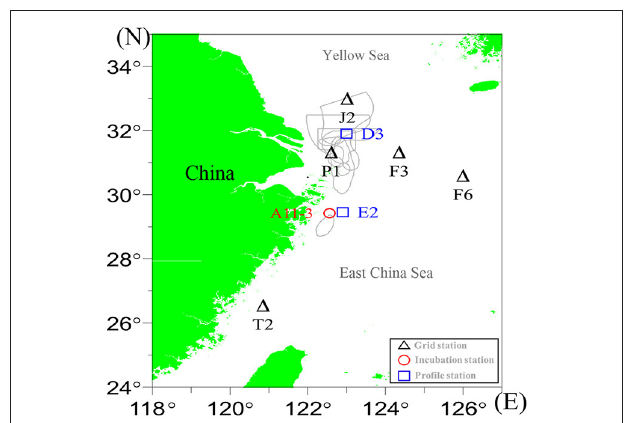
FIGURE 1 | The study area and sampling stations. Gray lines indicate the observed hypoxia in previous studies derived from Zhu et al. (2011).